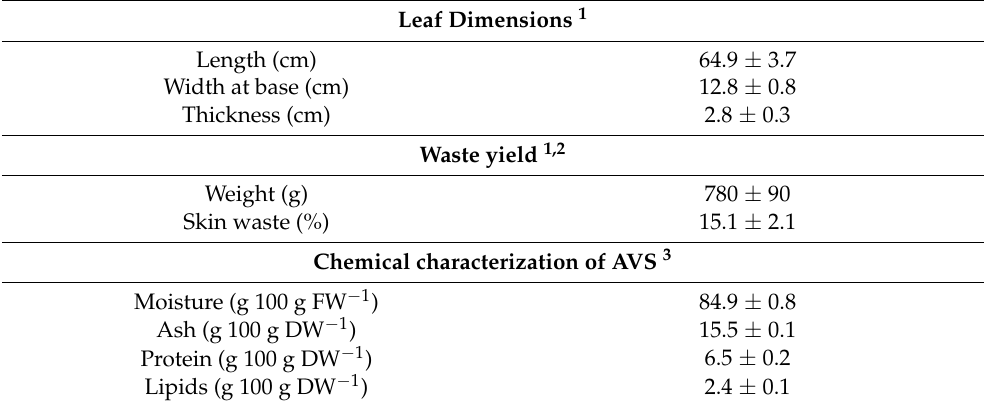
Table 1. Leaf dimensions, Aloe vera waste yield and chemical characterization of Aloe vera skin (AVS). Results are expressed as mean ±